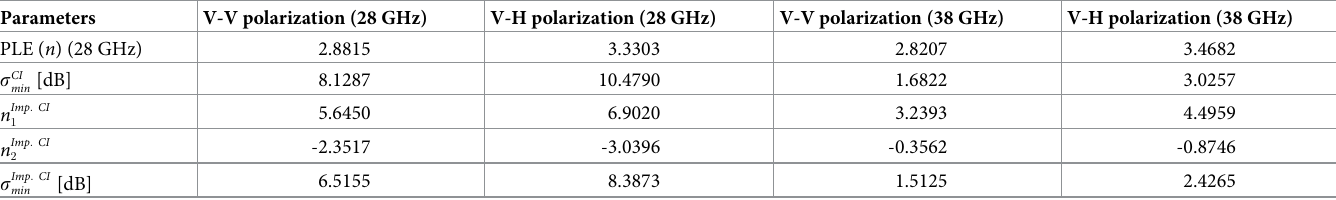
Table 3. Parameters for the standard CI and improved CI models for the NLOS